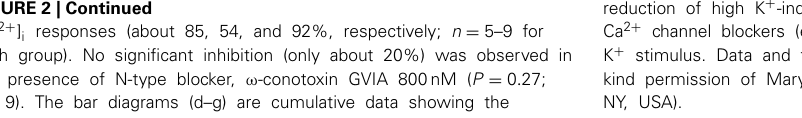
The experimental approaches of identification and characterization appear in blue color, while the protocol for stem cell culture and differentiation appears in black color. FACS, Fluorescence-activated cell sorting; IHC, Immunohistochemistry. The figure was produced using Servier Medical